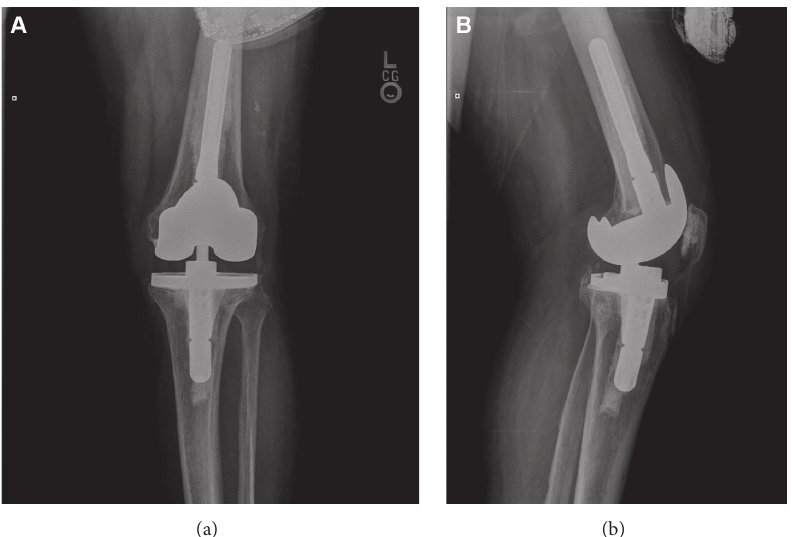
Figure 2: Anterior-posterior (a) and lateral (b) radiographs after second stage of reimplantation of cemented revision left total knee